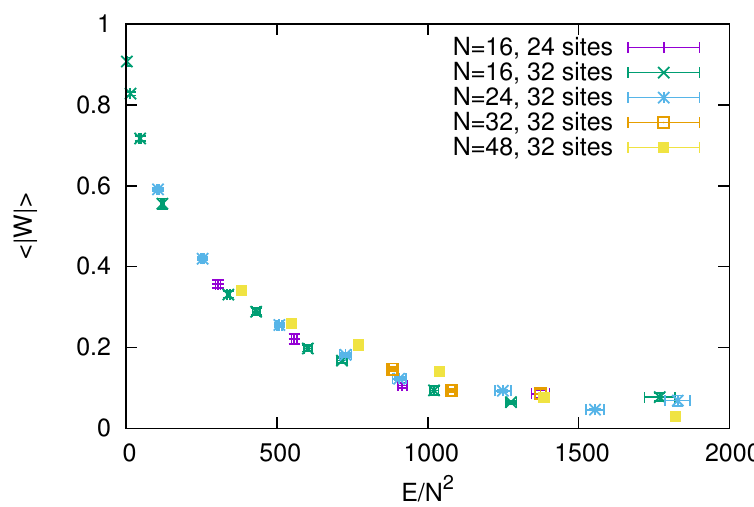
Figure 4 . Equilibrium Wilson loop expectation value versus energy in classical statistical simula- tions for various values of N and two lattice